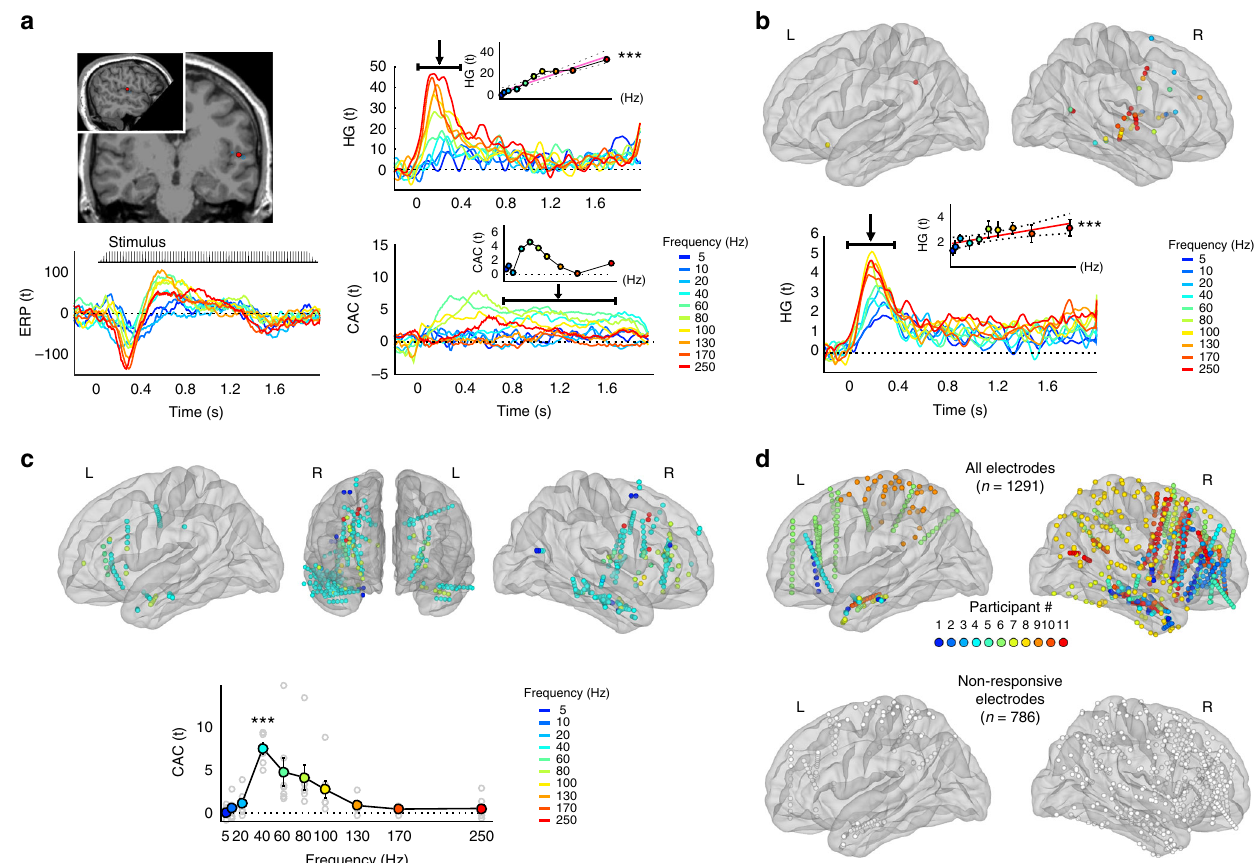
Fig. 2 HG and CAC spatial response patterns differ across stimulation frequencies. a Neural responses to click trains in a representative electrode situated in the right primary auditory cortex (Heschl ’ s Gyrus) of patient S1. Lower left plot: time course of un fi ltered event-related responses to the stimuli expressed in t-values relative to baseline. Responses are aligned with an exemplar of a stimulus (here a 40 Hz click train). Upper right plot: time course of high-gamma [HG, 70 – 200 Hz] amplitude in response to the stimulus, expressed in t-values relative to baseline, as a function of click train frequency (ranging from 5 Hz, blue to 250 Hz, red). HG onset [0 – 0.4 s] response is linearly proportional to the rate of the stimulus (upper inset). Lower right plot: magnitude squared stimulus-brain coherence (cerebro-acoustic coherence, CAC, expressed in t -values relative to baseline). CAC shows a sustained pattern through the duration of the stimulus that varies nonlinearly as a function of the stimulus rate and is prominent in the roughness range (40 – 100 Hz; lower inset). b – d Neural responses to click trains across all eleven patients. b Upper panel: spatial location of electrodes exhibiting signi fi cant HG onset responses to sounds. Colours represent the stimulation frequency at which HG response is maximal. Lower plot: time course of HG [70 – 200 Hz] responses averaged across these electrodes, expressed in t-values relative to baseline, as a function of stimulus frequency. HG amplitude at the response onset [0 – 400 ms] is linearly proportional to the rate of the stimulus (inset). c Electrodes showing sustained, signi fi cant stimulus-brain coherence (CAC) are spatially located in widespread cerebral areas. Colours represent the stimulation frequency at which CAC is maximal. Lower plot: CAC as a function of stimulus rate. Light grey circles correspond to individual data. d . Top panels: spatial location of all electrodes, colour-coded as a function of participant number. Lower panel: spatial location of electrodes that did not show any signi fi cant HG or CAC response. Error bars indicate SEM. Asterisks in panels a and b indicate signi fi cant correlation with stimulus frequency: *** indicates signi fi cant p -values at